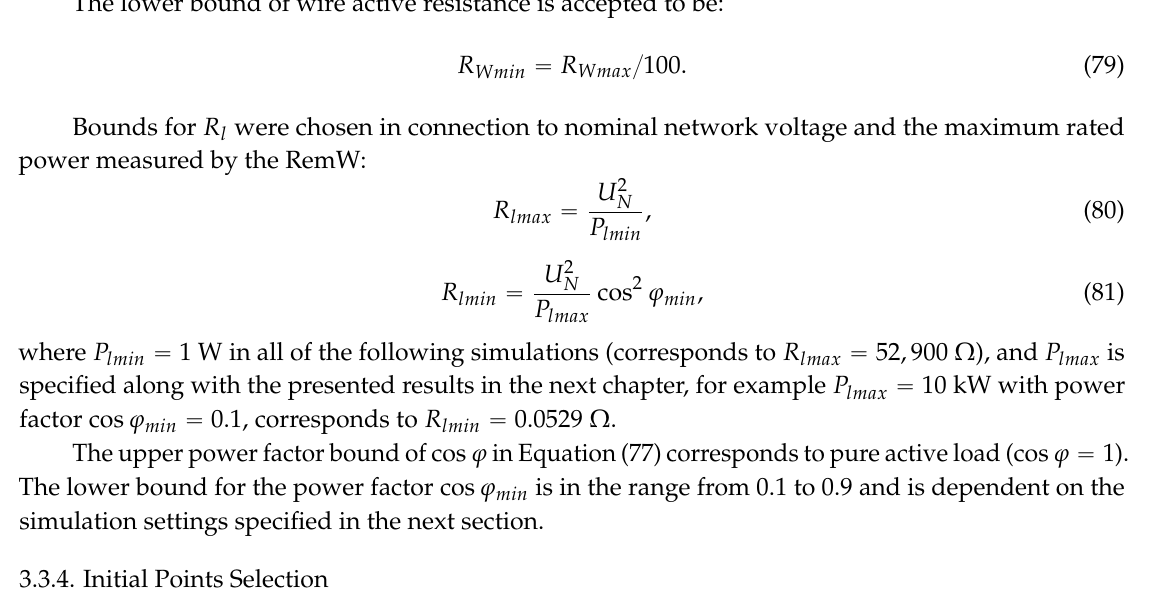
Figure 8. Error dependence on the wiring resistance 𝑅 𝑤 . Figure 9. Error dependence on the load power factor cos 𝜑 .